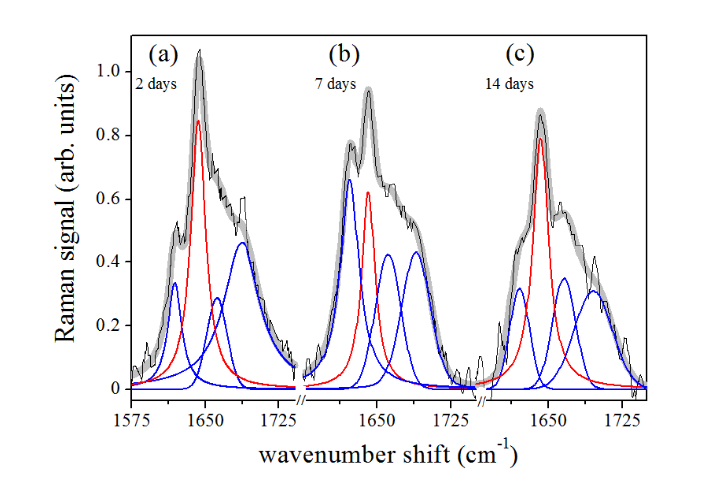
Figure 4. Deconvolution of PDL Raman spectrum in the Amide I region. Data were obtained by averaging the Raman response of control samples. The α -helix component (red line) and other main components (blue lines) of the Raman band are indicated.